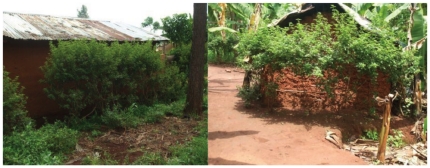
Lantana planted around a house in the study village.The plants grew rapidly to cover the sides of the houses where mosquitoes enter through small openings and eaves.